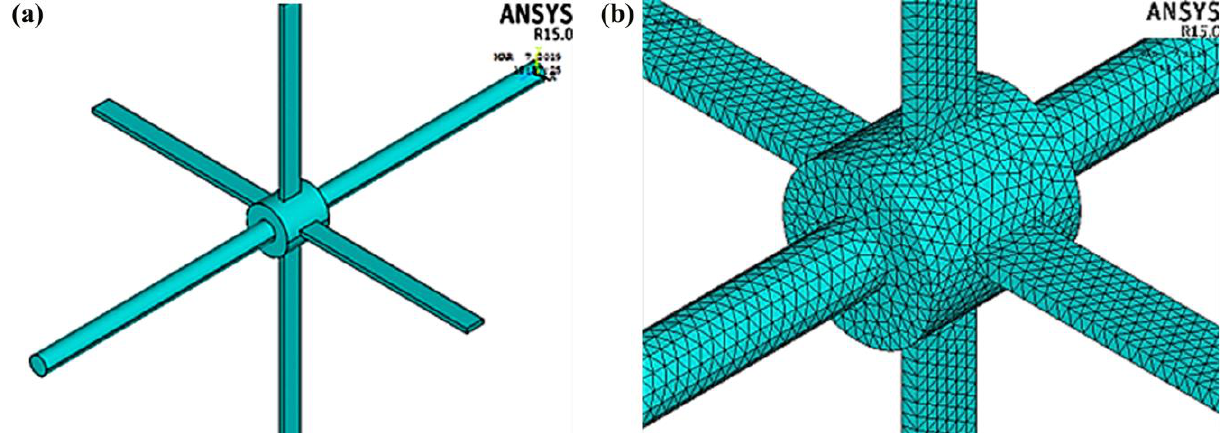
Figure 1. ( a ) Geometric and ( b ) finite element models of the shaft. The boundary condition for the rotating blades is shown in Figure 2. For shell 63 (4 node shell element), every node has 6 degrees of freedom, 3 translations, Ux, Uy and Uz, and 3 rotations: Rotx, Roty and Rotz. Ux, and Uy degrees of freedom of the nodes, which are at supports, are constrained to simulate the actual condition of rotating